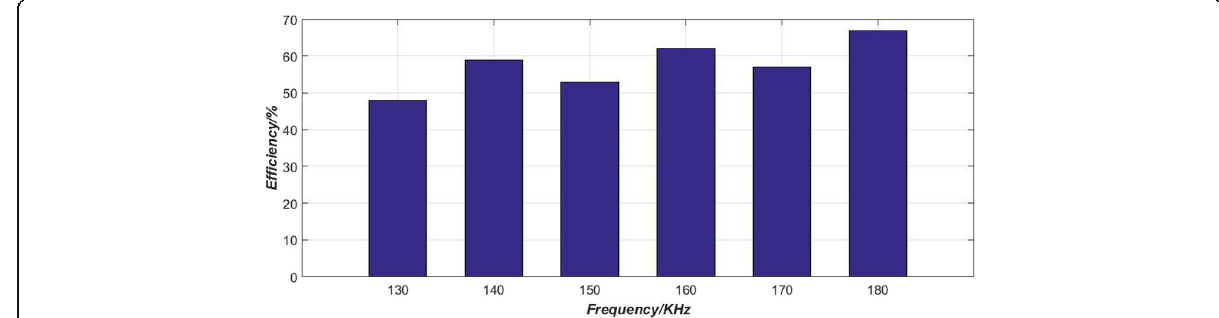
Fig. 14 The power transmission efficiency of the wireless power transfer (WPT) system at different